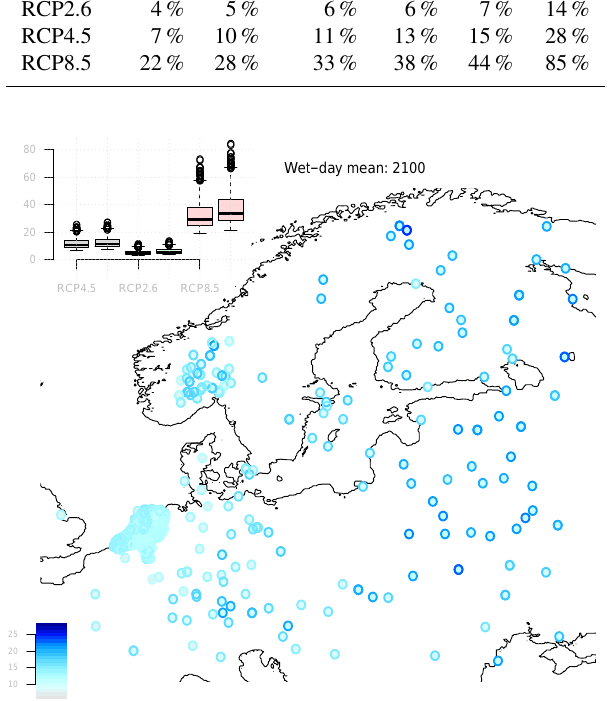
Figure 3. Projected local change from 2010 to 2100 in the ensem- ble mean and 95th percentile annual mean µ for the RCP4.5 emis- sion scenario. The colour of the inner part of the symbols indicates changes in the ensemble mean and the outer part the 95th percentile in terms of percentages since 2010. The inset shows a boxplot of the projected change in µ , both for the ensemble mean (left) and the 95th percentile (right) of emission scenarios RCP4.5, 2.6